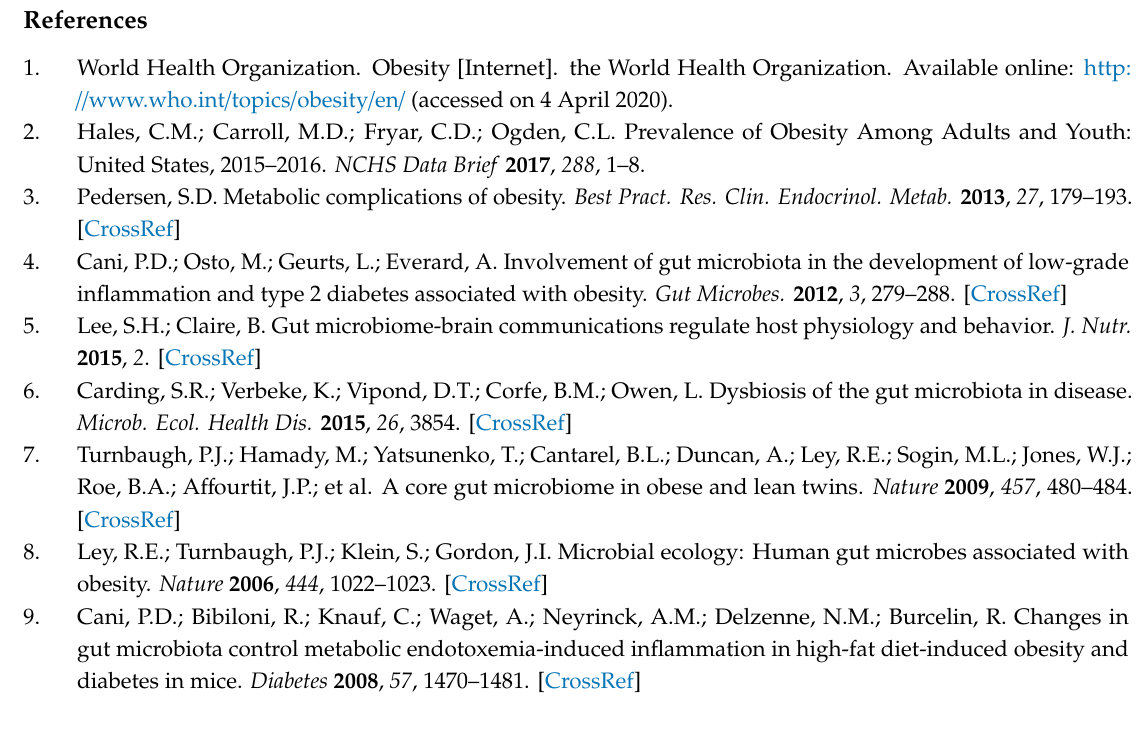
Table S1. Diet composition of LF and HF diets, Table S2. Primer sequences used for RT-PCR, Table S3. ANOVA data summary, Figure S1. Experimental design of the study, Figure S2. E ff ect of 10% 2 (cid:48) -FL supplementation on the composition of the gut microbiota, Figure S3. Histogram of the LDA scores from LEfSe analysis, showing the most di ff erentially abundant taxa enriched in microbiota from mice fed an LF, HF, or 2FL (in drinking water, w / v ) diet for 6 weeks, Figure S4. Water